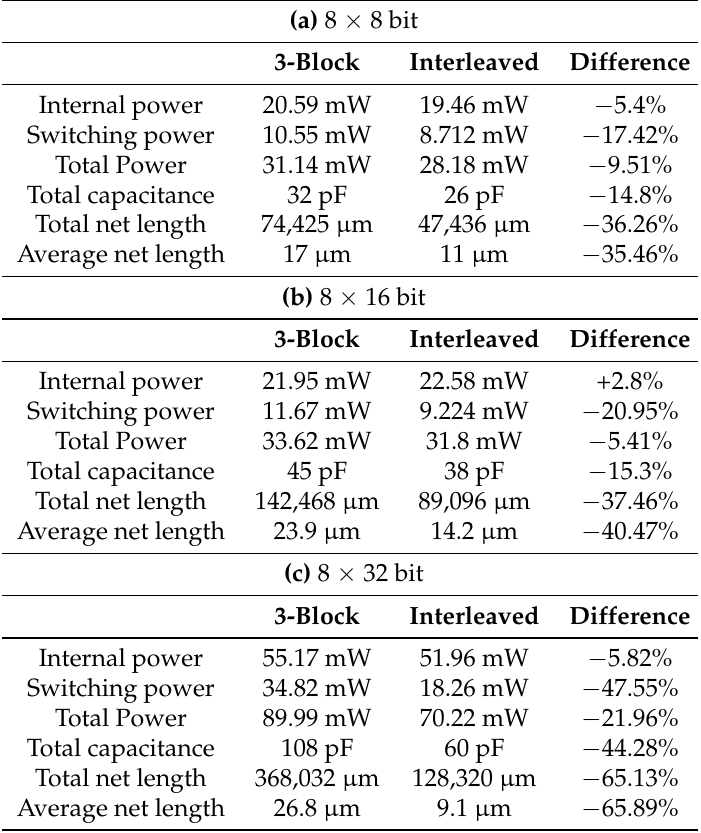
Table 2. Performance